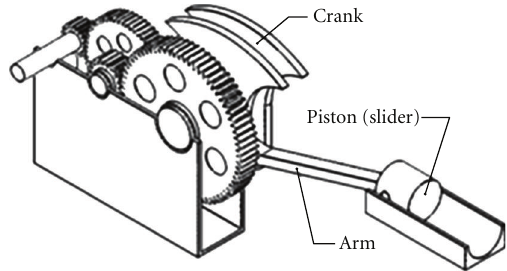
Figure 1: Crank-slider mechanism.